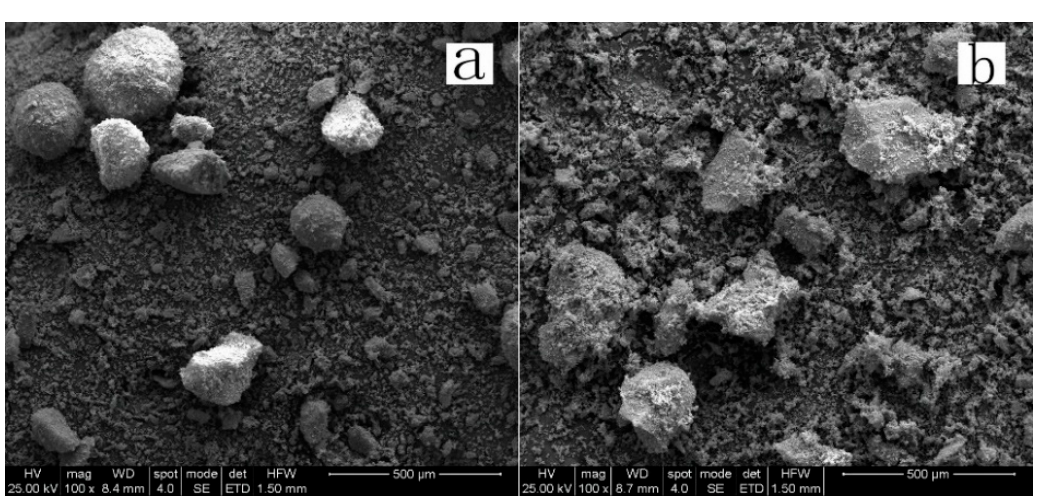
Figure 17. BSE images of 150 °C leach residues. Scale: ( a ) 500 μ m; ( b ) 100 μ m.